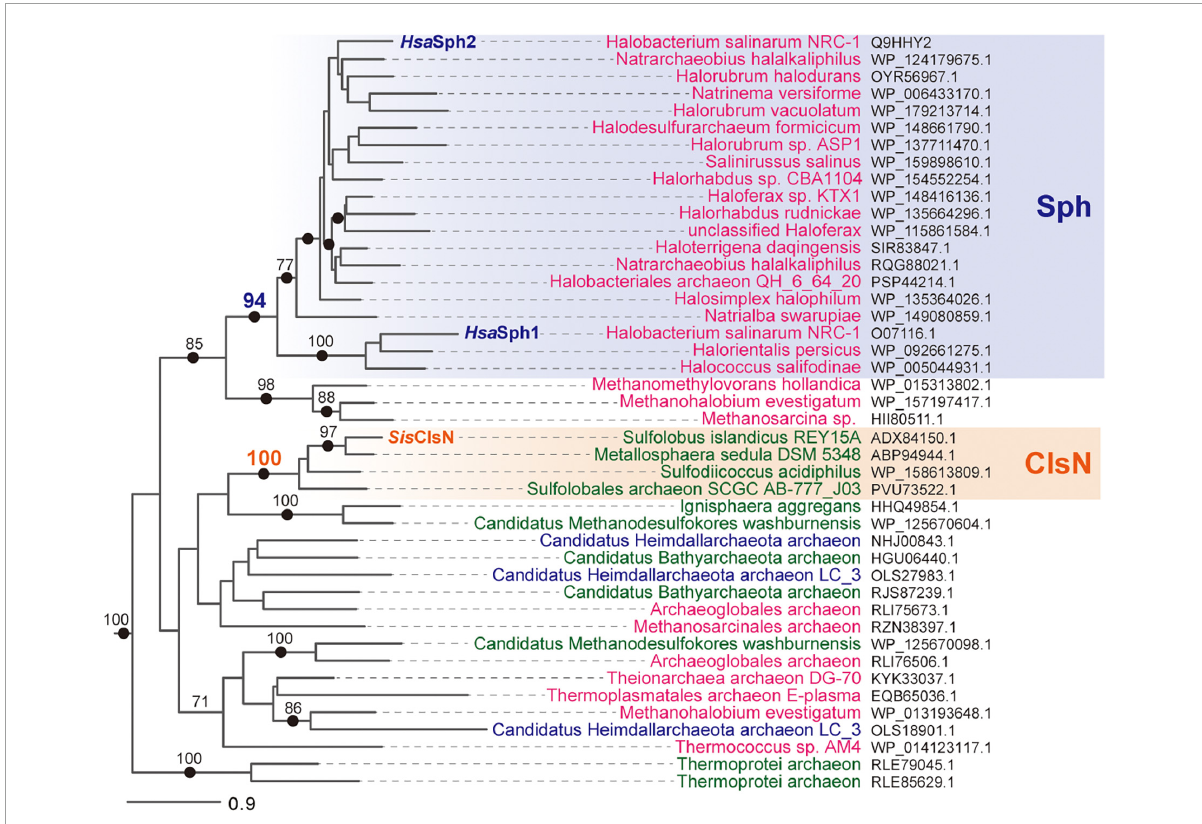
FIGURE4 Phylogenetic relationship among 44 ASRP sequences including Sis ClsN, Hsa Sph1, and Hsa Sph2. The second alignment, which contained 44 ASRP and 28 archaeal SMC sequences, was subjected to both maximum-likelihood (ML) and Bayesian phylogenetic analyses. There was no substantial incongruity between the ML and Bayesian trees, and thus only the ML tree is shown. Only the clade of the ASRP sequences was presented. Non-parametric ML bootstrap support values greater than 70% and Bayesian posterior probabilities greater than 0.95 (indicated by closed dots) were shown on the corresponding nodes. The ASRP sequences of euryarchaea, crenarchaea, and Asgard archaea are colored in magenta, green, and dark blue, respectively. The Sph and ClsN clades are shaded in blue and orange,